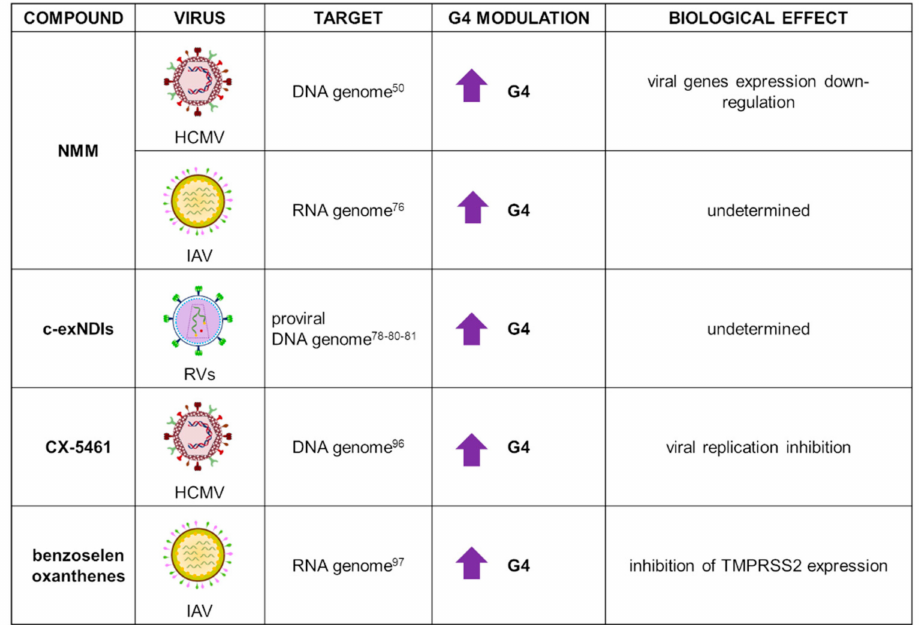
Figure 5. Summary of NMM, c-exNDI, CX-5461, and benzoselenoxanthene applications as G4 ligands in virology. For each target virus, the site of action (also known as the G4 location), the modulatory effect on G4s, and the overall biological outcome are